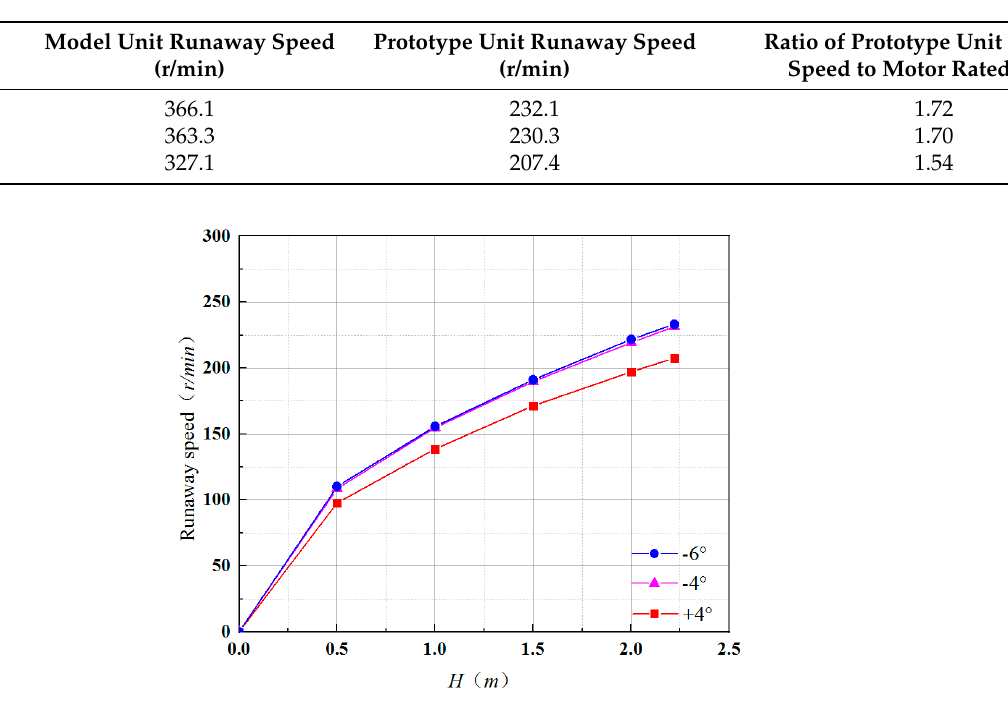
Figure 9. Runaway characteristic curve of the prototype pumping device.